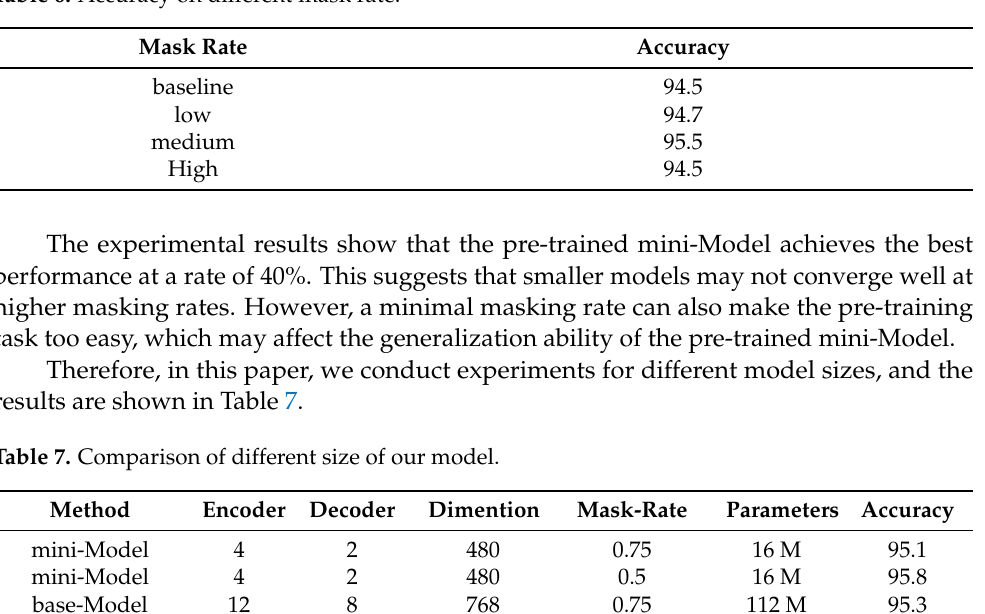
Table 6. Accuracy on different mask rate.